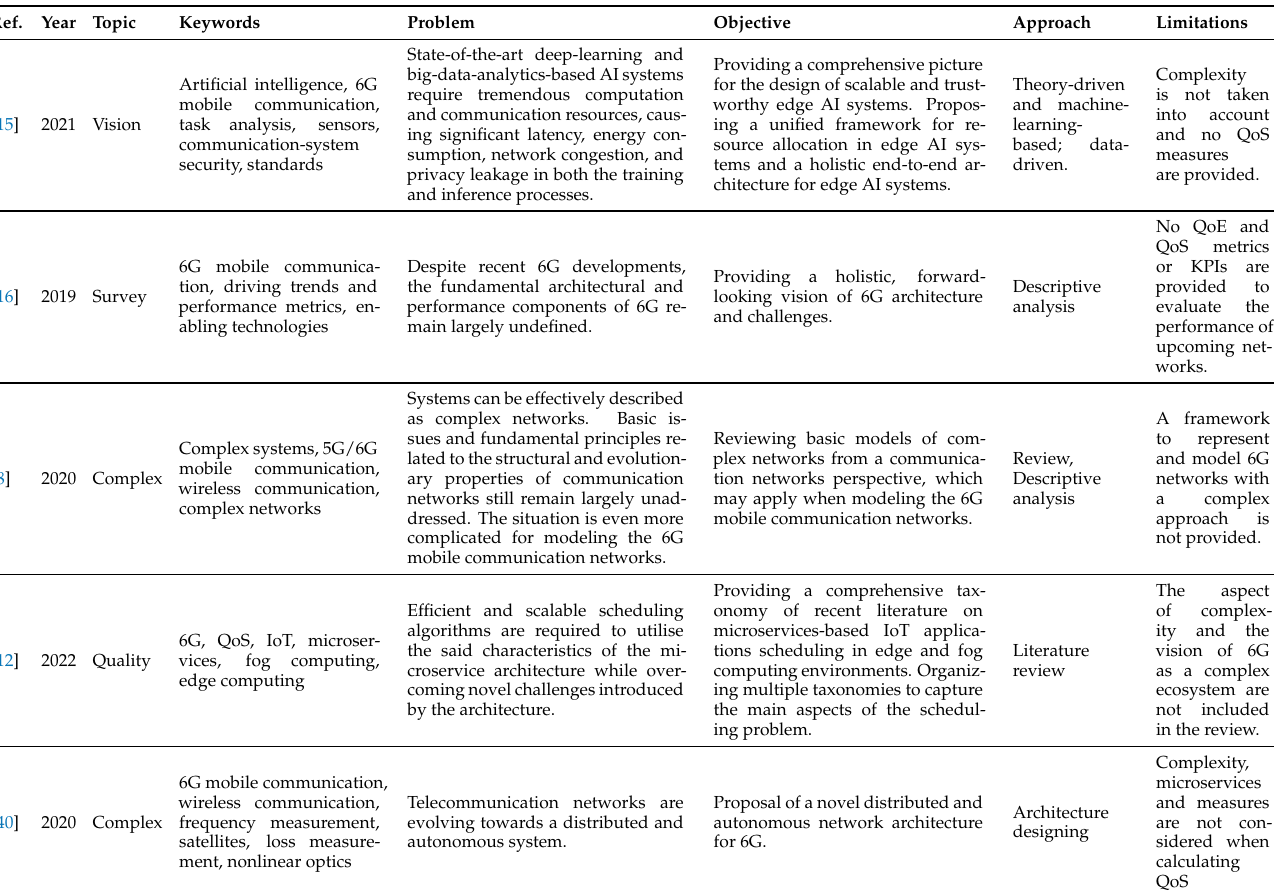
Table 1. Summary of state-of-the-art contributions related to 6G paradigm, complex approach to the future of mobile communications and the